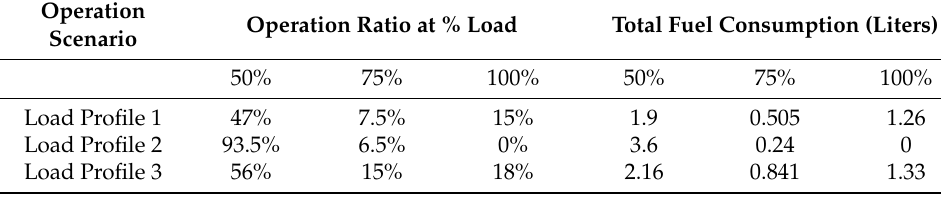
Table 3. DGen fuel consumption without FESS.